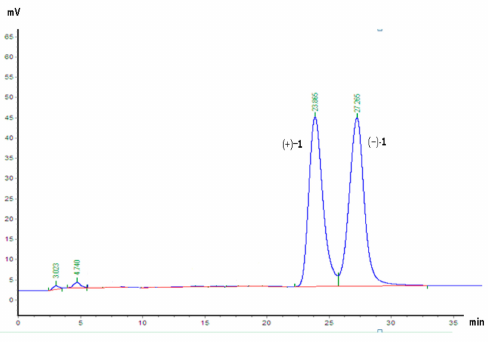
Figure 3. The HPLC separation chromatogram of (+)- 1 and ( − )- 1 on chiral AD-H column (5 µ m,